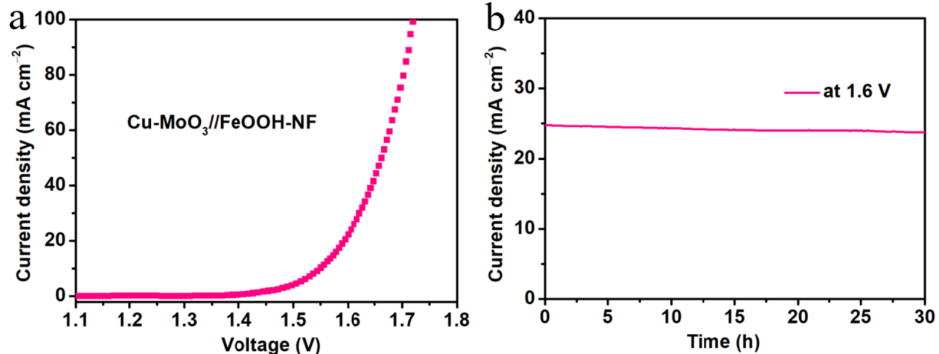
Figure 8. ( a ) The polarization curve of Cu-MoO 3 //FeOOH-NF water electrolyzer. ( b ) The stability test of Cu-MoO 3 //FeOOH-NF water electrolyzer at 1.6 V in an alkaline